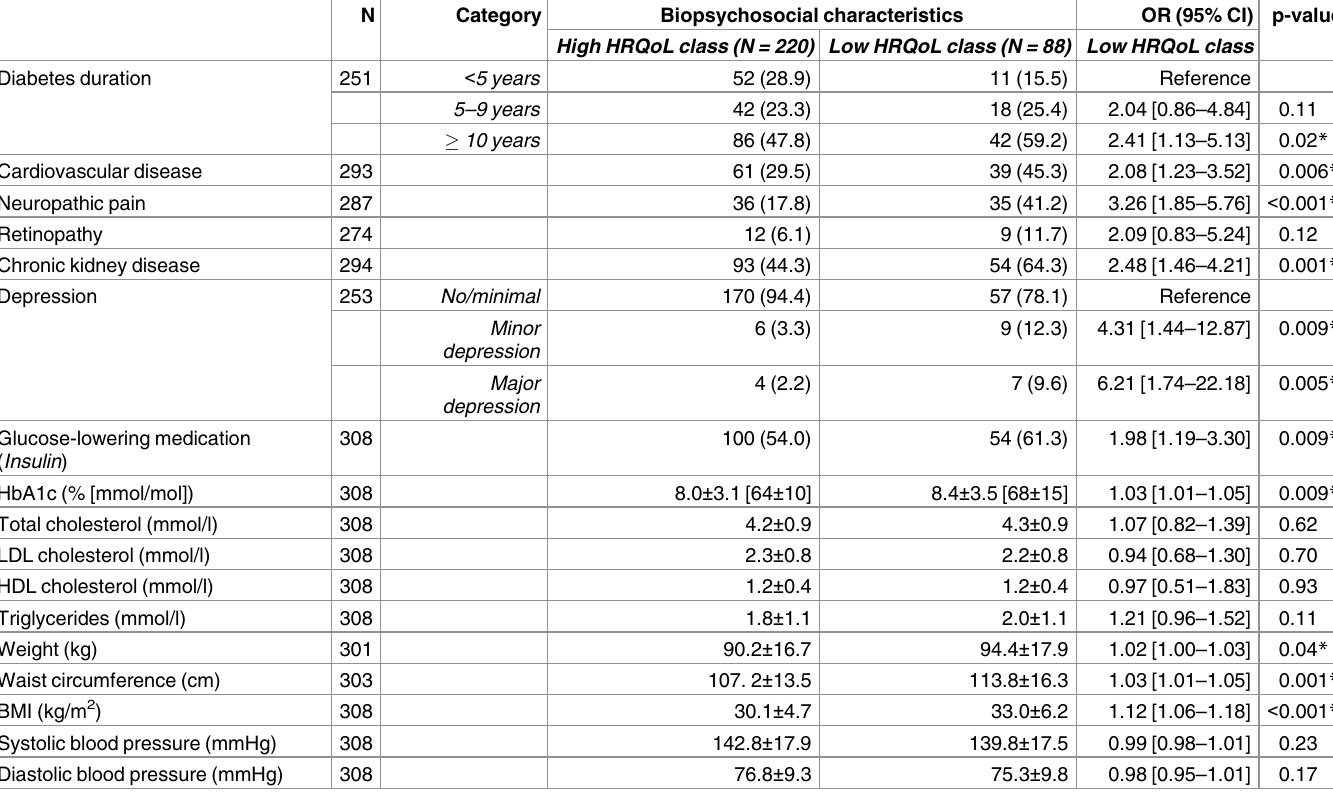
Table 8. Health-related characteristics of T2DM patient across different classesof